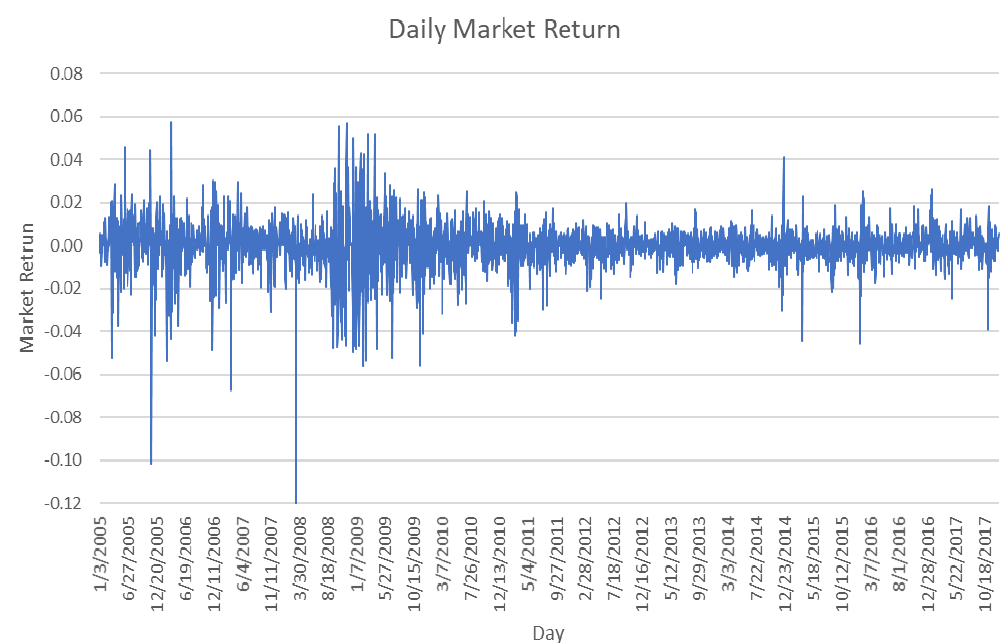
Figure 1. Daily market return for the period from January 2005 to the end of